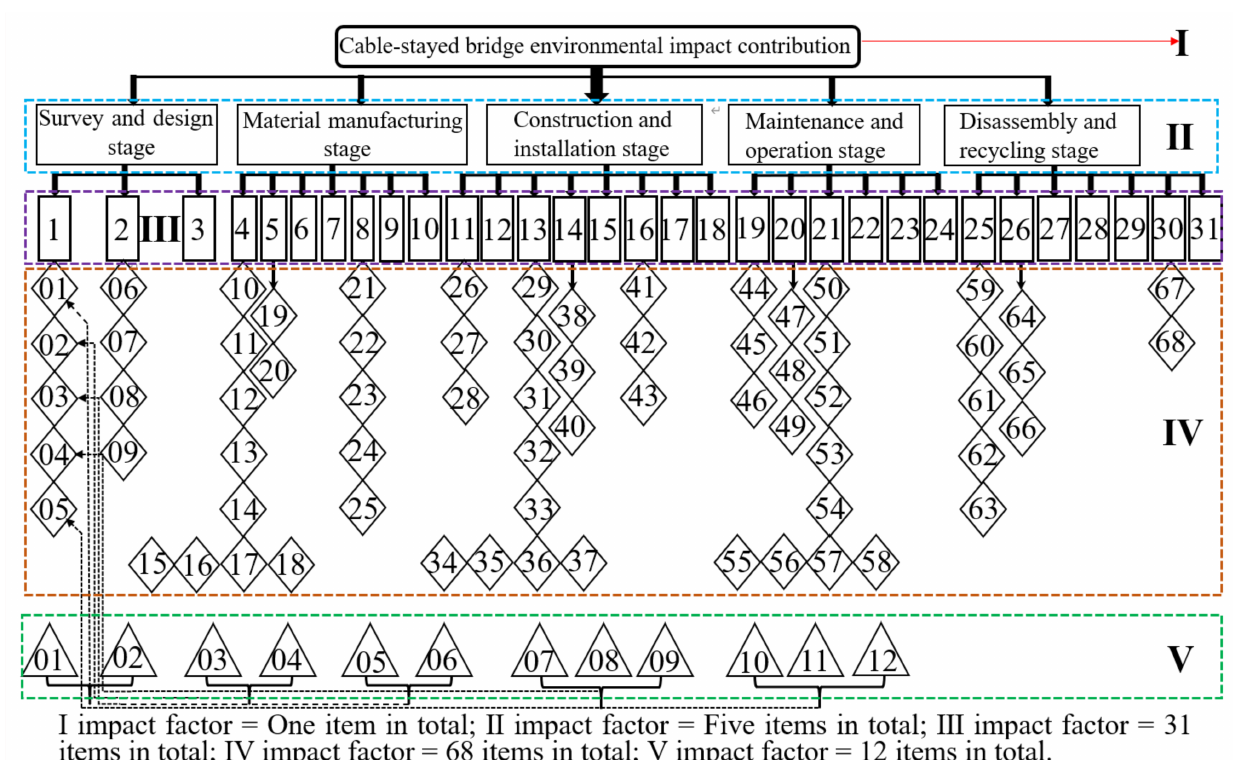
Figure 5. Schematic diagram of tree-shaped BN of environmental impact contribution of cable-stayed bridge. Description: There are a total of 117 environmental impact factors for cable-stayed bridges. The amount of data information is huge—see the attached table for relevant